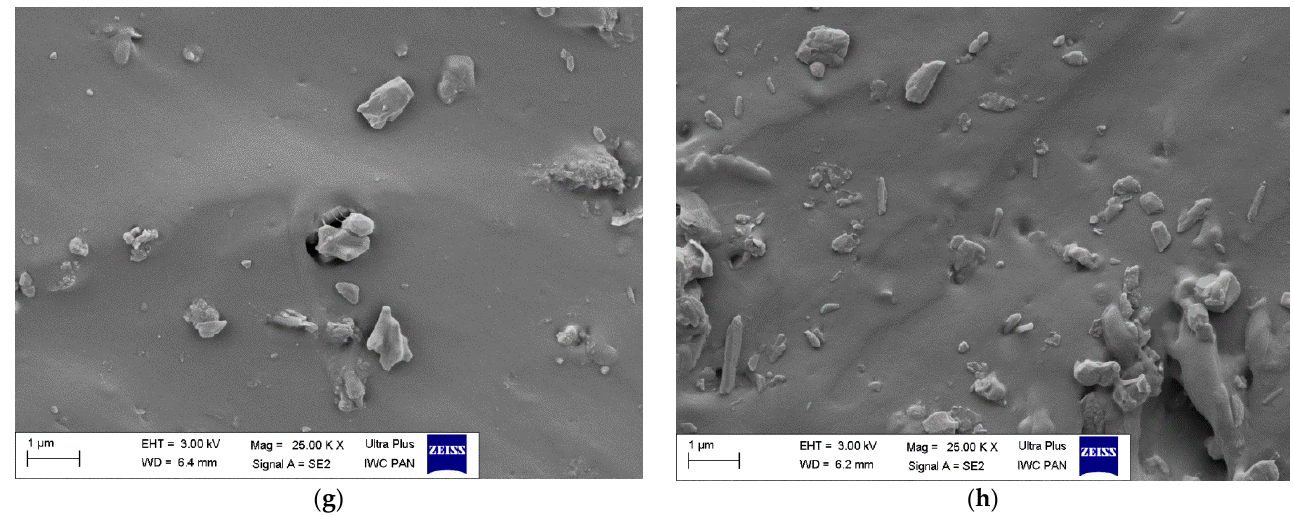
Figure 5. Scanning electron microscopy (SEM) microphotographs of pure SiC filler particles ( a , b ) and EPDM vulcanizates containing: ( c ) 5 phr of SiC; ( d ) 15 phr of SiC; ( e ) 10 phr of SiC and 5 phr of SiO 2 ; ( f ) 10 phr of SiC and 5 phr of CB; ( g ) 10 phr of SiC and 5 phr of xGnP; ( h ) 10 phr of SiC and 5 phr of HAL.